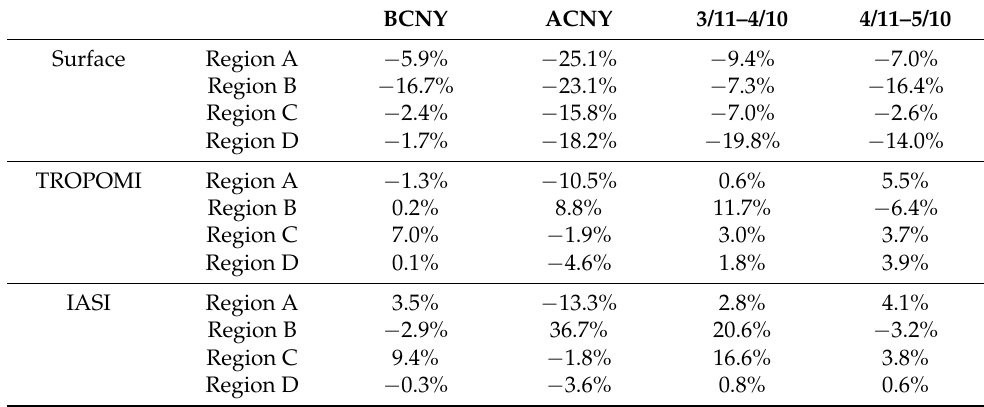
Table 2. The median of the relative changes in CO surface concentration observed by surface measurements, and in CO columns observed by TROPOMI and IASI satellite measurements during four periods in each